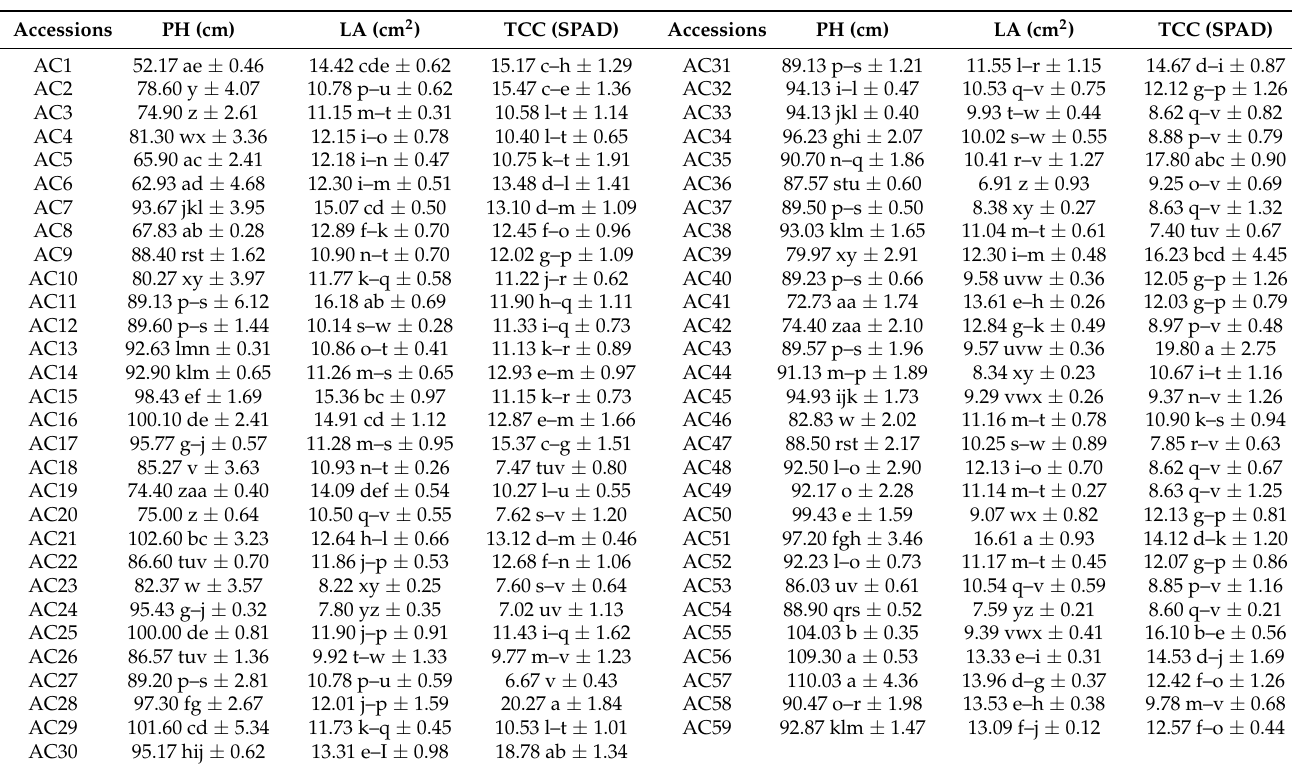
Table 4. Mean pairwise comparison between 59 barley accessions for three growth traits under treatment with MOE and control